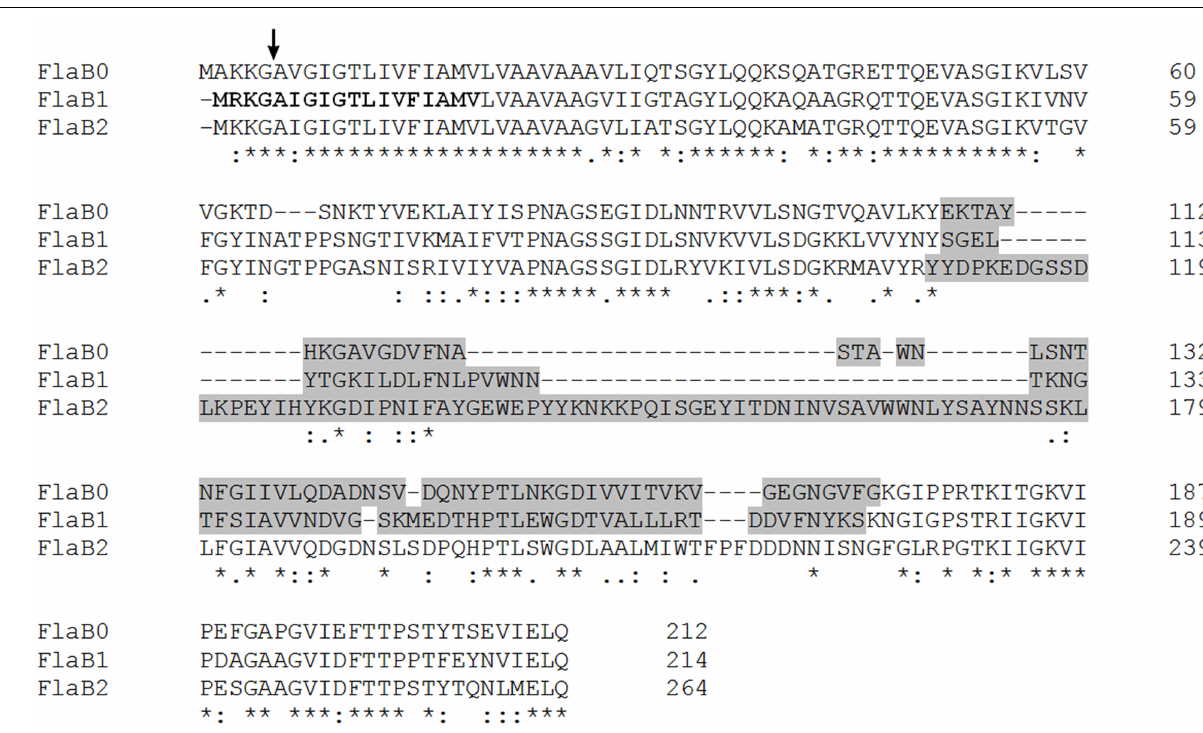
represent the FlaB1 sequence correction resulting from the resequencing performed in this study. Regions indicated by gray sequences identify the least conserved central part of the proteins used to raise flagellin-specific antibodies (primers used for cloning are given in Materials and